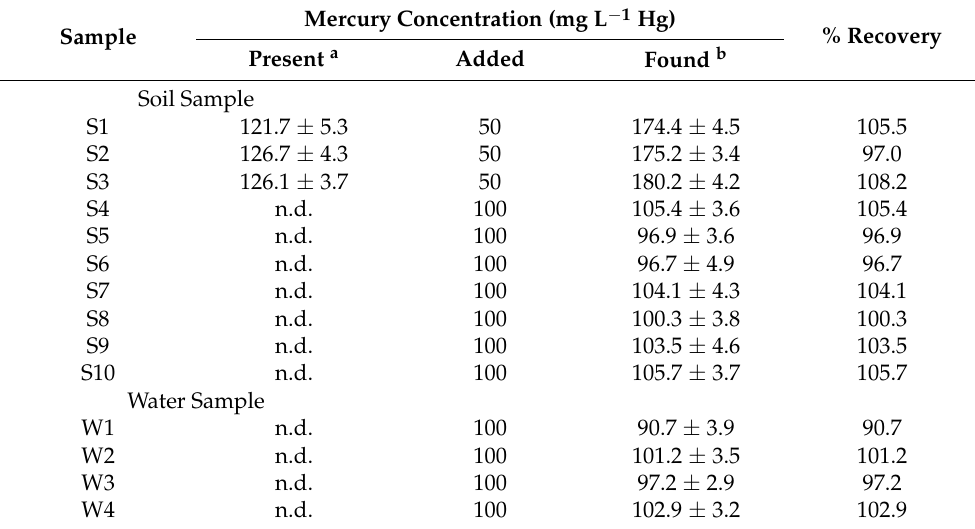
Table 3. Percentage recovery of mercury in soil and water samples using the µ